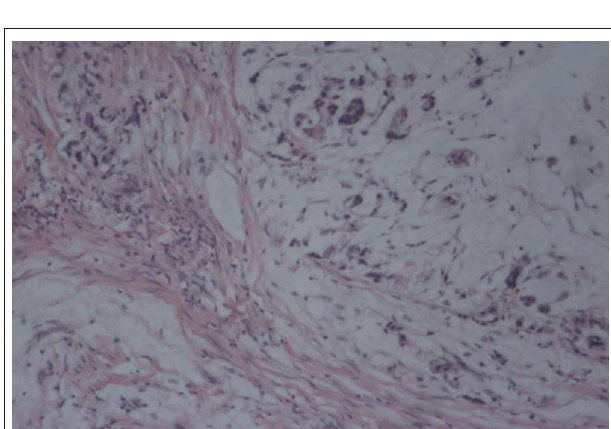
FIGURE 3 | Histology revealed that the rectal tumor is a mucinous adenocarcinoma.